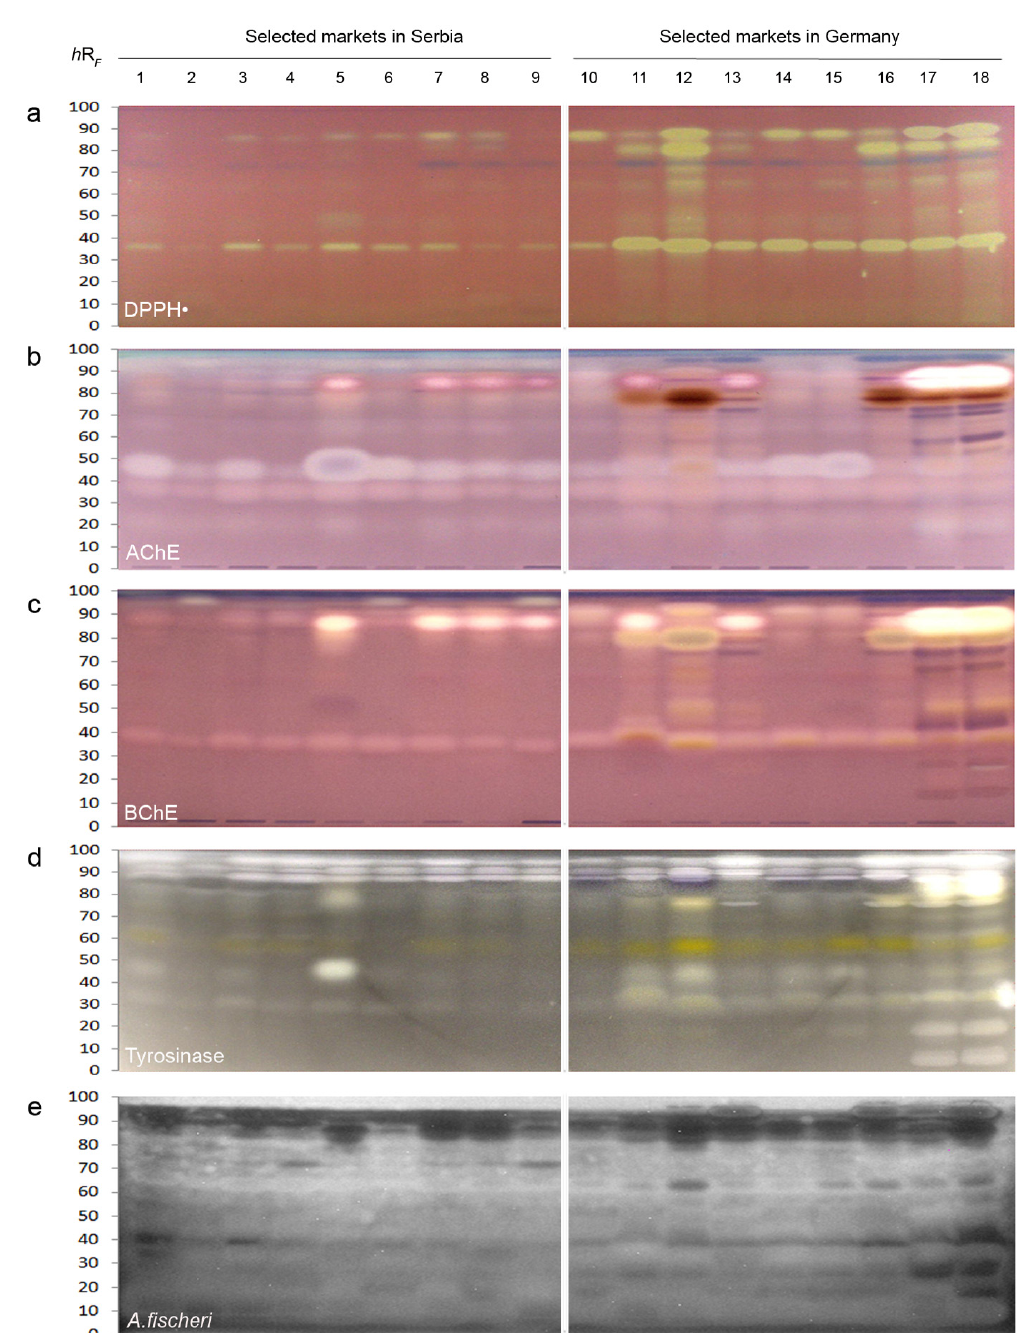
Figure 2. HPTLC profiles of extracts of apple juices from selected markets in Serbia and Germany after the ( a ) DPPH • assay, ( b ) acetylcholinesterase (AChE), ( c ) butyrylcholinesterase (BChE),